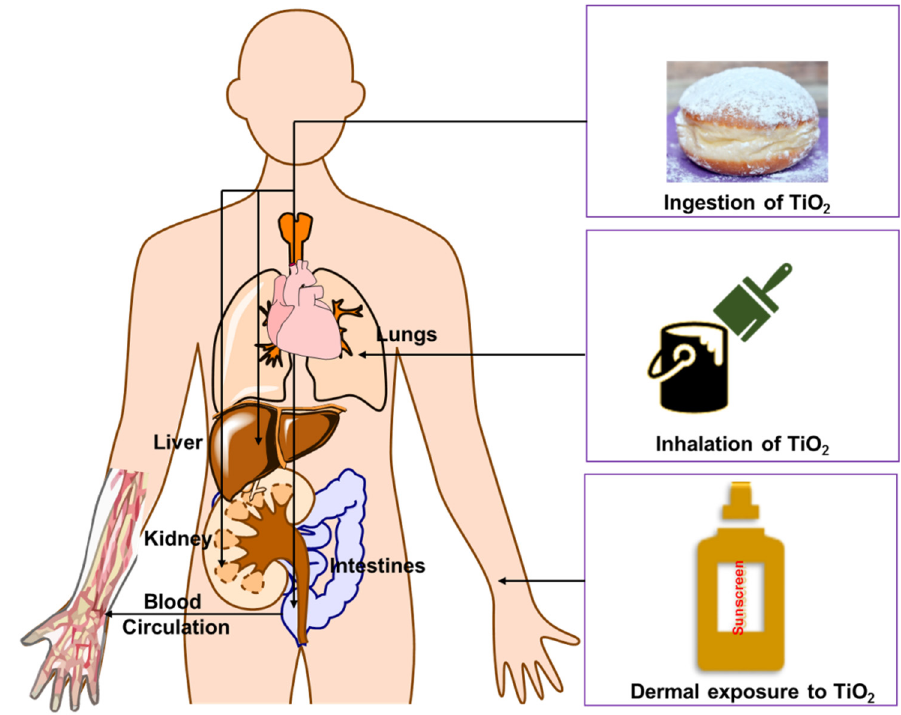
Figure 4. Different pathways by which TiO 2 nanoparticles can enter and distribute in the human body.